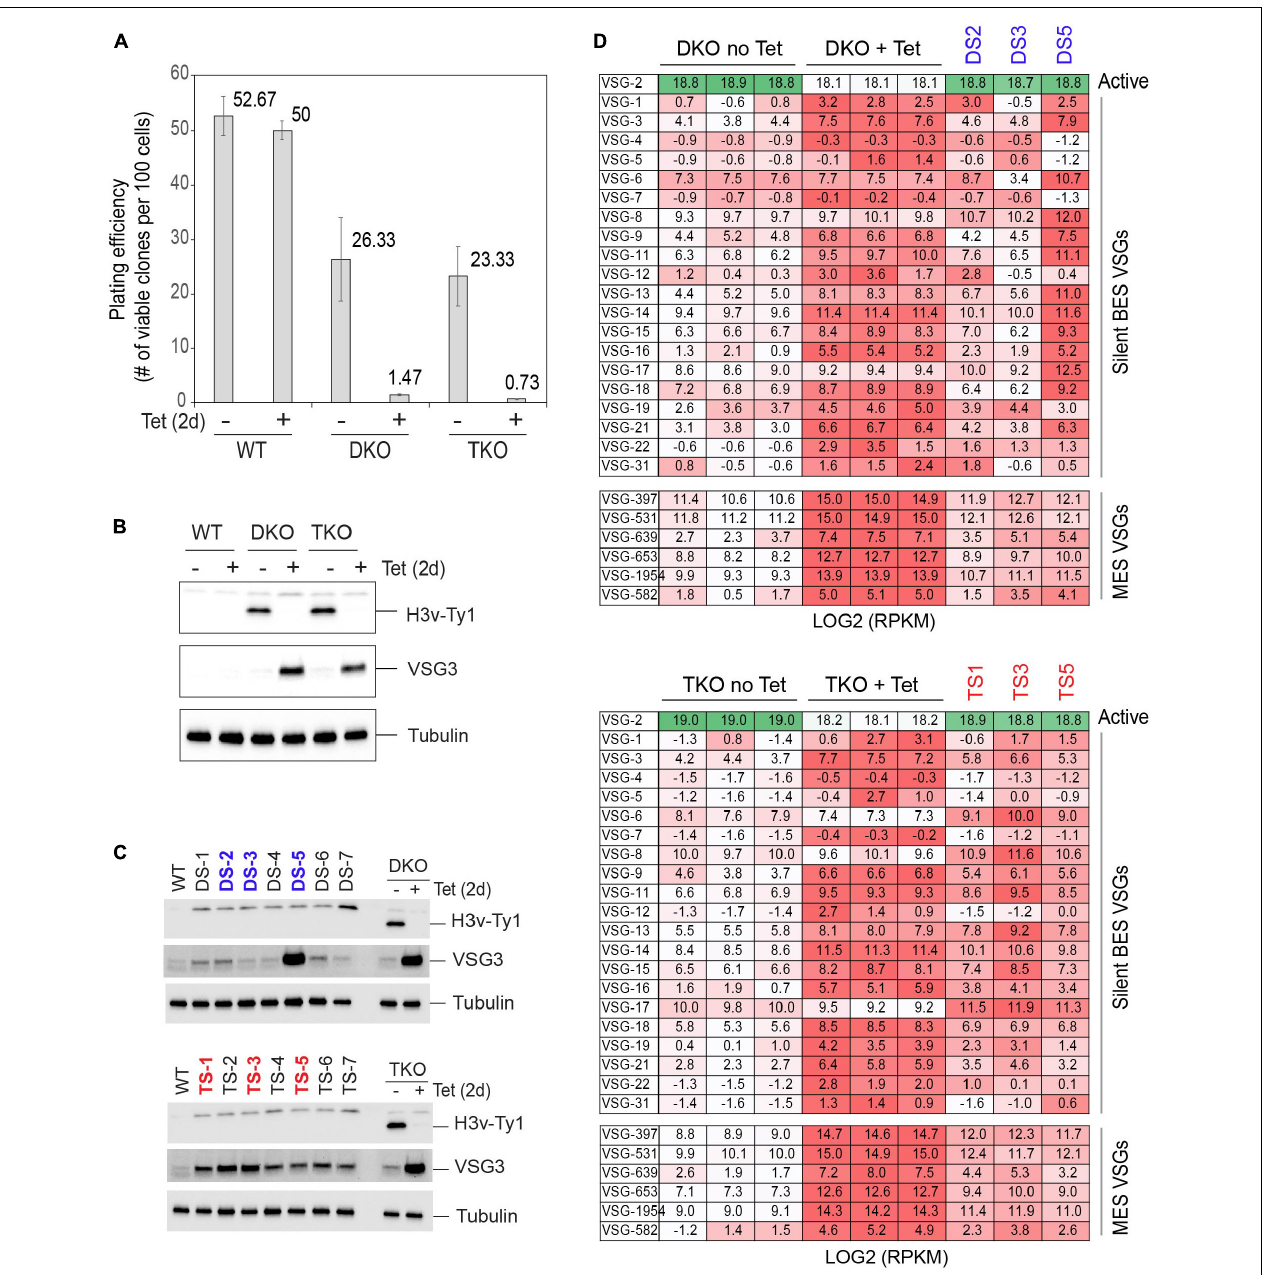
FIGURE 6 | Emergence of survivors after the removal of H3v in DKO and TKO mutants: VSG silencing phenotypes. (A) Plating efficiency after H3v-Ty1 removal in DKO and TKO strains. WT, DKO, and TKO strains were treated with tetracycline for 2 days to remove H3v-Ty1 allele. One hundred or 1,000 cells were distributed in 96-well plates, and the number of wells containing live cells was counted to determine the viability. Clones that are resistant to puromycin were excluded as they may grow because they still retain the H3v-Ty1-PUR allele. Error bars indicate standard deviation between three replicates. (B) Western blot confirming the absence of H3v-Ty1 protein in Tet-treated cells in (A) . (C) Silent VSG3 protein expression in survivors emerged after removing H3v-Ty1. Seven of survivor clones from DKO (DS 1–7) or TKO (TS 1–7) were examined for silent VSG3 expression by western blot. (D) VSG silencing in DS and TS clones was examined by stranded RNA-seq (rRNA depletion). Heat maps compare DKO replicates (-/+ Tet) and DS clones and TKO replicates (-/+ Tet) and TS clones for BES and MES VSG transcript levels (darker color = higher expression